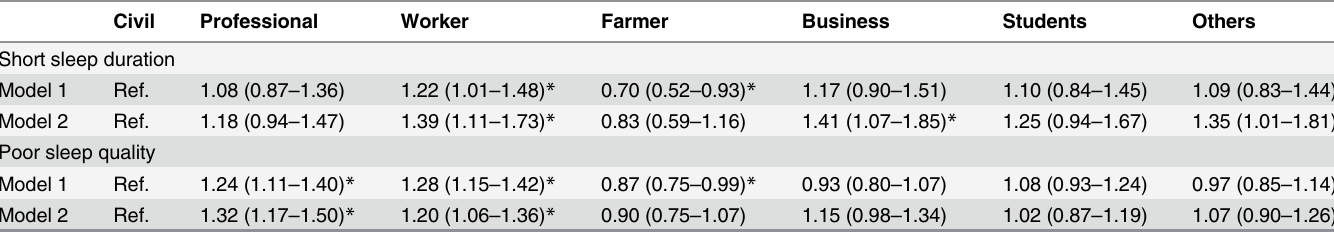
Table 3. Multiple logistic regression models and the associations between occupations, sleep duration, and sleep